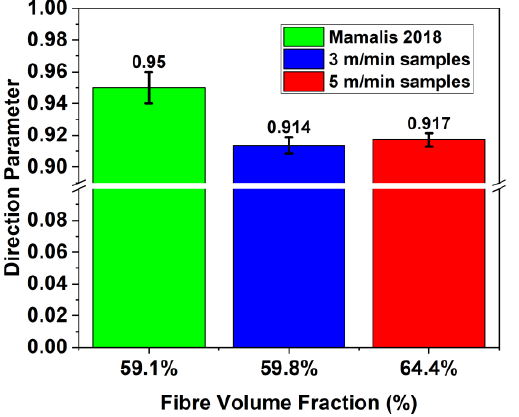
Figure 8. Direction parameter for different FVF samples compared to that of Mamalis et al. [14].